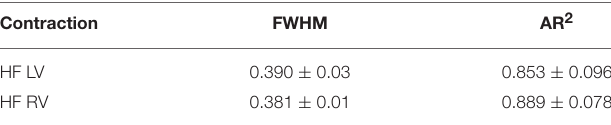
Frontiers in Physiology |